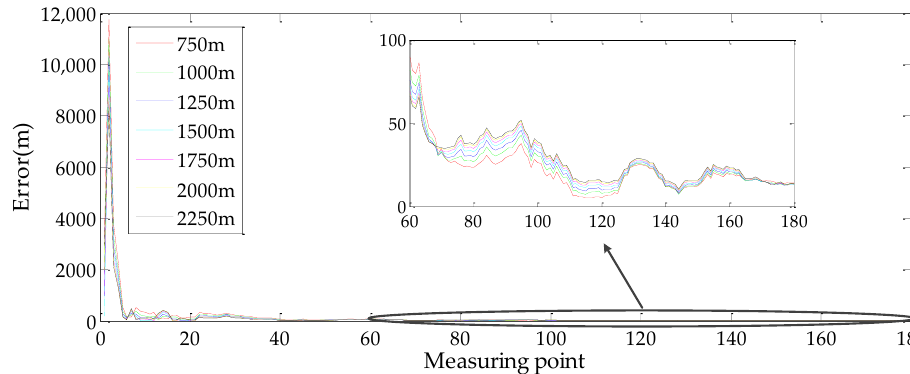
Figure 9. Influence of the target elevation error on the geo-location accuracy.